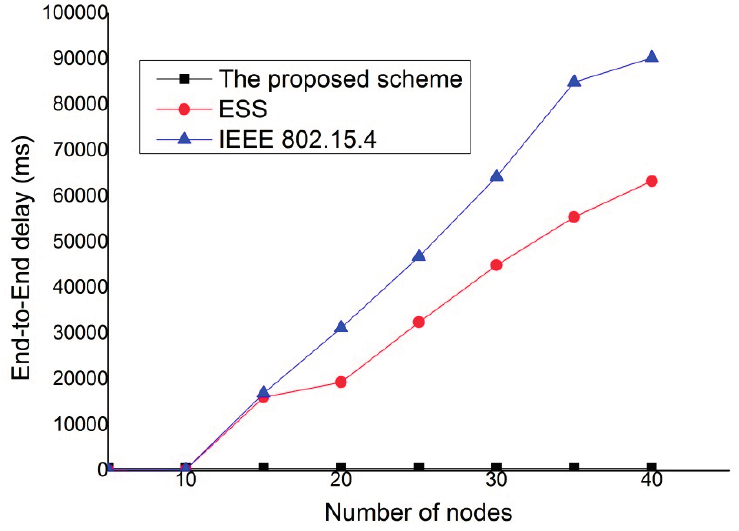
Figure 17. End-to-End delay for different node densities.